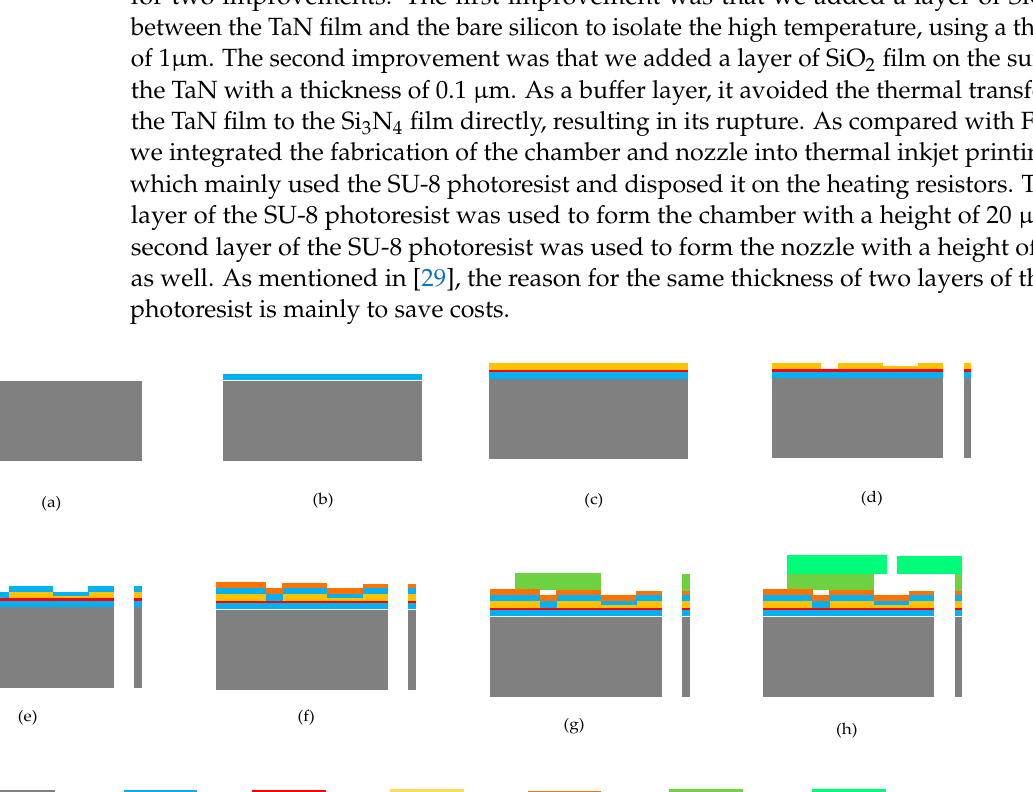
Figure 11. The structure of thermal bubble inkjet chip: ( a ) the overall preview of the thermal bubble inkjet chip; ( b ) the internal structure of the thermal bubble inkjet chip; ( c ) the positions of the TaN chopsticks-shaped heating resistors.